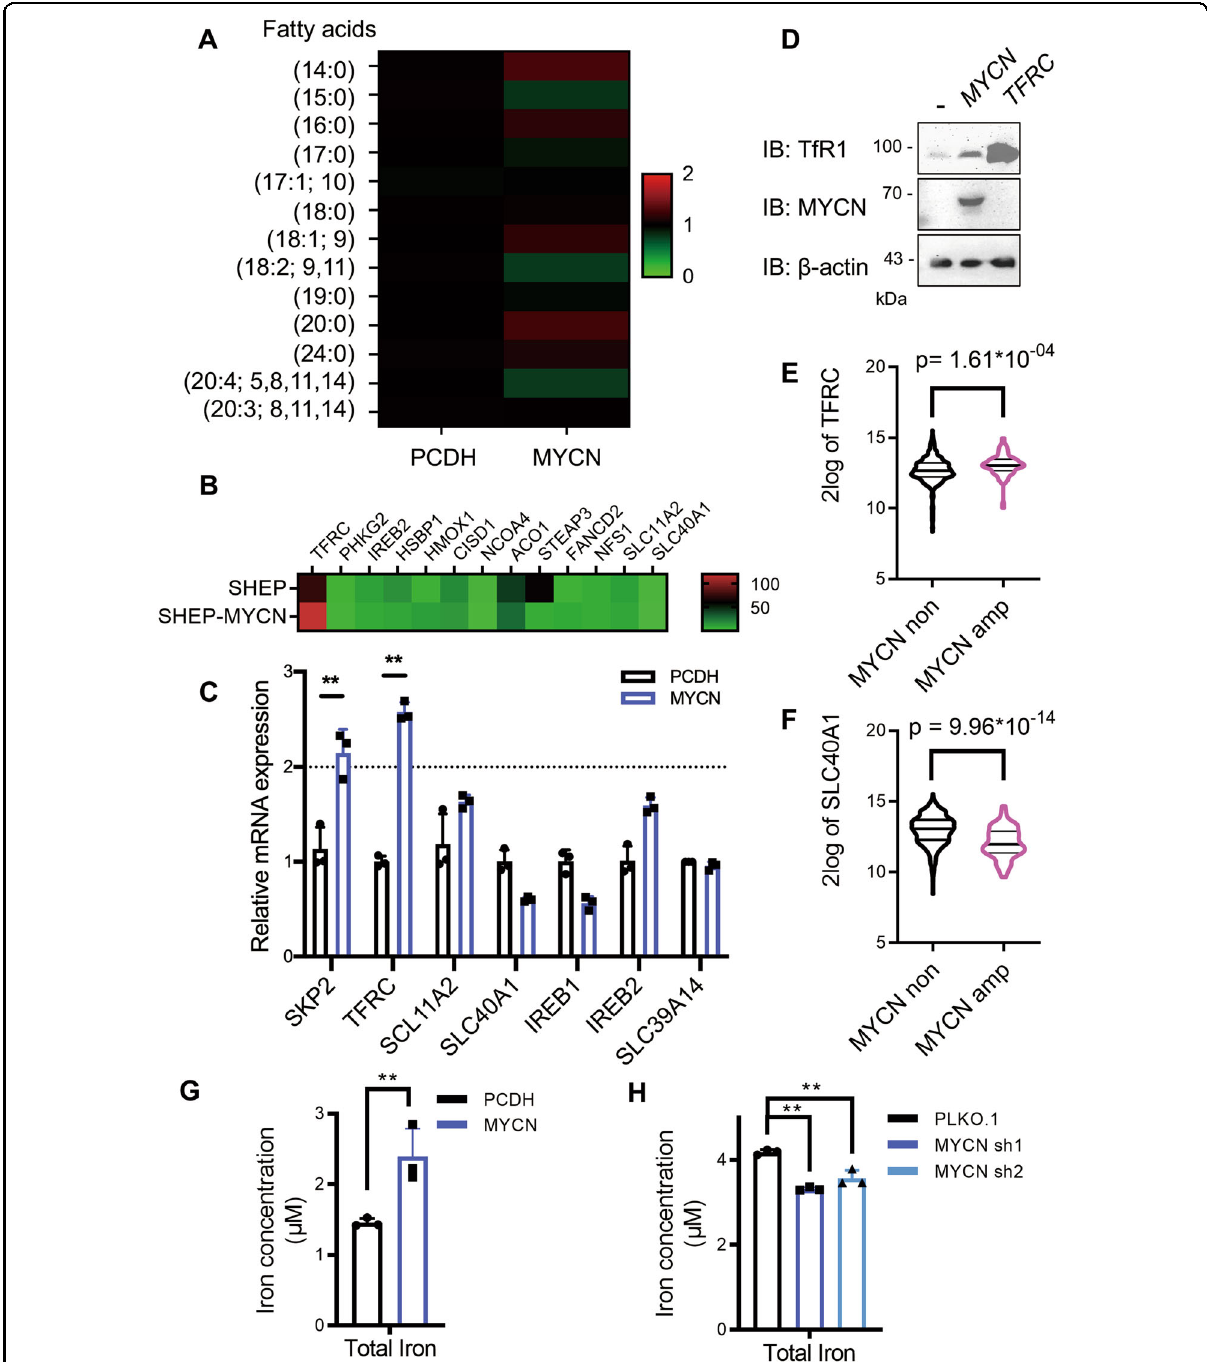
Fig. 3 MYCN increases the intracellular iron load. A Heatmap showing changes in an array of fatty acids in SHEP cells with or without MYCN . Data are shown as relative changes in abundance compared to the PCDH vector. B Heatmap showing the expression pro fi le of ferroptosis-associated metabolic genes. C Expression of MYCN induced iron metabolic genes analyzed by RT-qPCR, and SKP2 is positive control of MYCN targeted genes. D Western blot analysis of SHEP cells with or without MYCN expression using indicated antibodies. E , F TFRC and SLC40A1 expression in NB tumor tissues with or without MYCN ampli fi cation. Expression data were retrieved from GSE45547. Cellular iron load is detected with the colorimetric ferrozine-based assay in SHEP G and SK-N-BE2 H cells with or without MYCN, and values are normalized to protein concentration. Data are presented as mean ± SD of three replicates. Two-tailed unpaired t -tests were performed to calculate p values. ** p <